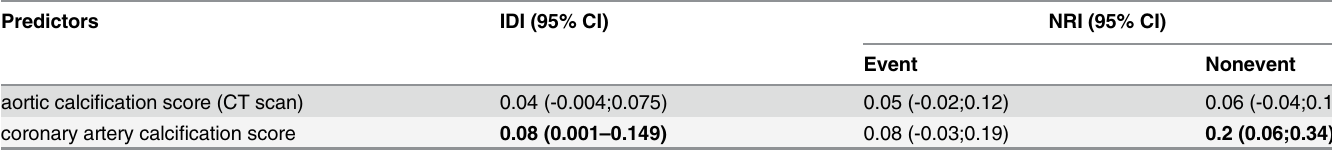
Table 4. Improvement in prediction of the composite endpoint by adding the aortic calcification score and the coronary artery calcification score to TRFs.